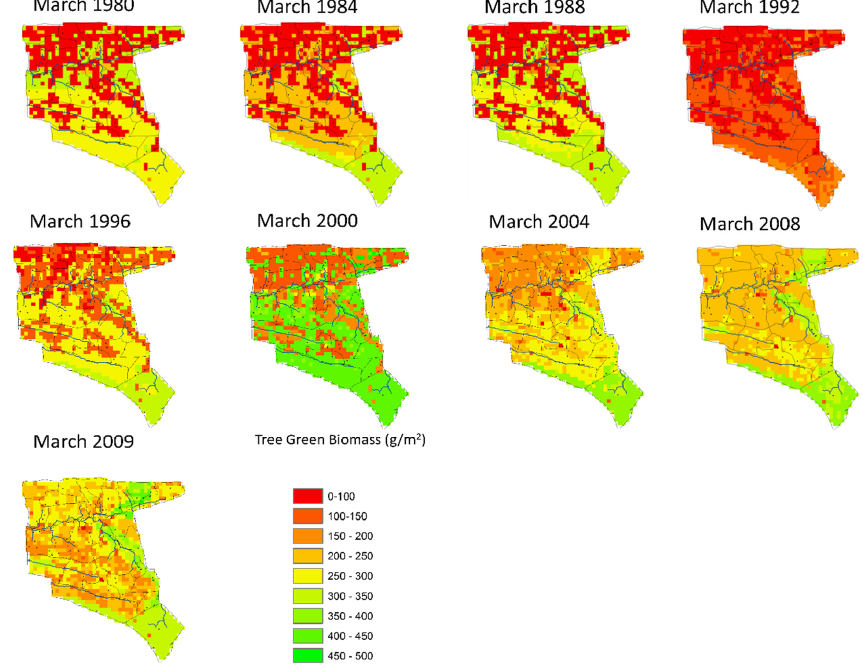
Figure 11. The spatial distribution of tree green biomass for selected years (March every 4th year of the historic scenario).